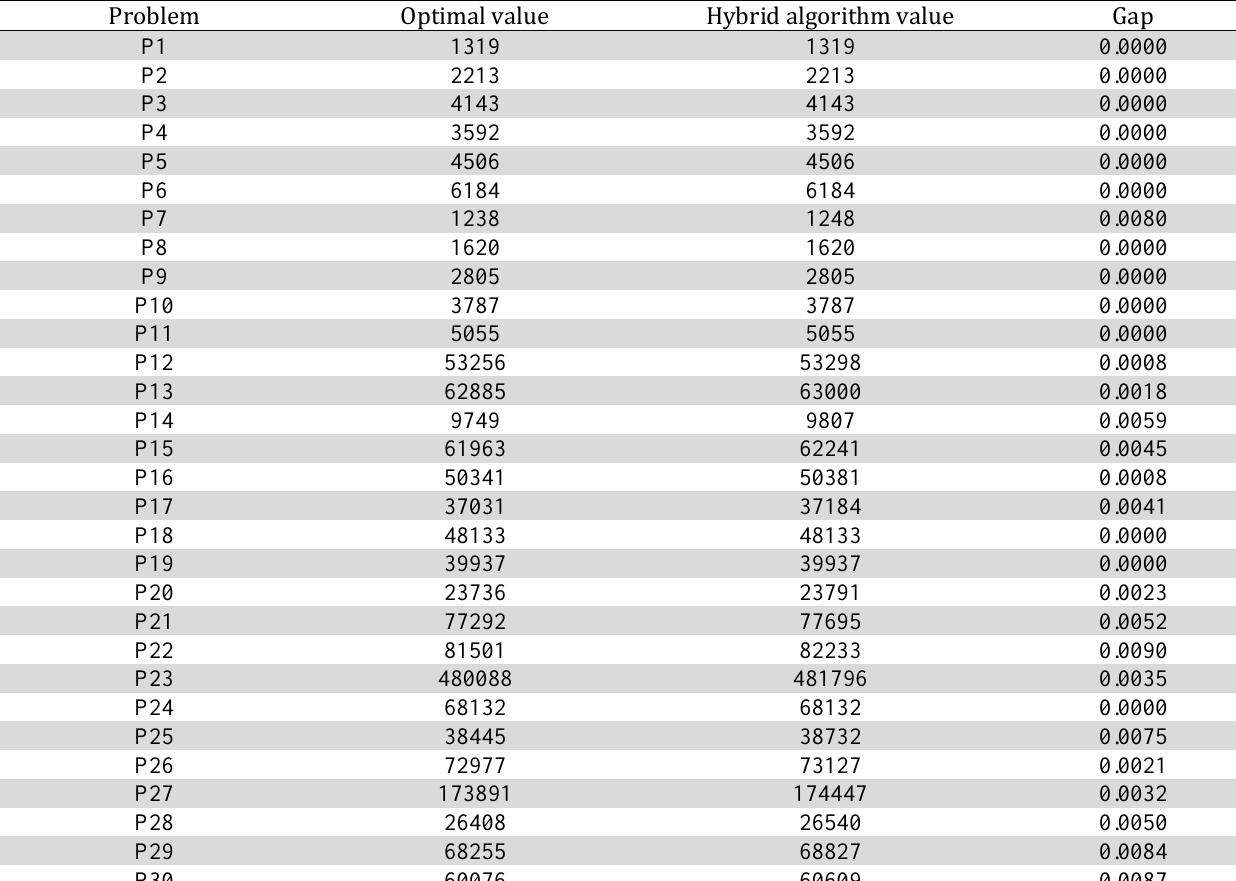
The results of hybrid algorithm values versus optimal values Problem